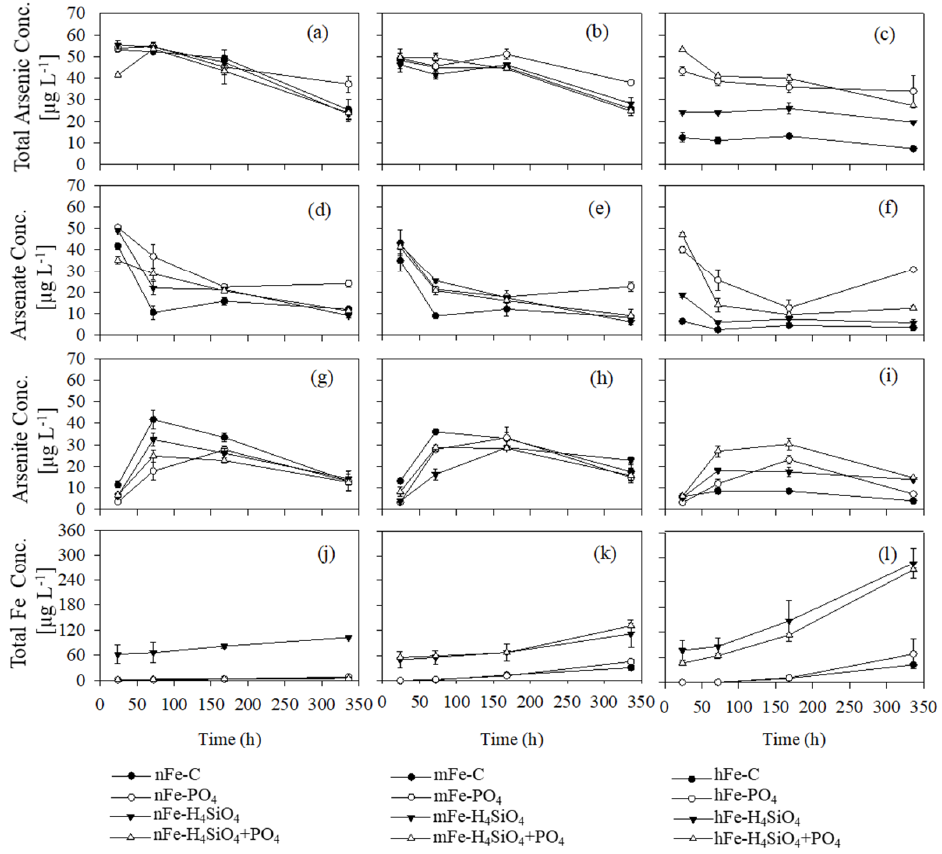
Figure 1. The concentration changes of total arsenic ( a – c ), arsenate ( d – f ), arsenite ( g – i ), and total iron ( j – l ) versus time upon anoxic incubation. Data represent the mean ( n = 3); whiskers represent the standard deviation ( n = 3). Phosphate: PO 4 ; silicic acid: H 4 SiO 4 ; control: C; goethite: Fe; no goethite: nFe; medium goethite: mFe; and high goethite: hFe. The solute concentration, i.e., the fraction of arsenate and arsenite in solution in- creased for all treatments in nFe and mFe systems (Figure 1d,e,g,h). However, in the hFe system, the concentrations of arsenate and arsenite were higher only in the presence of